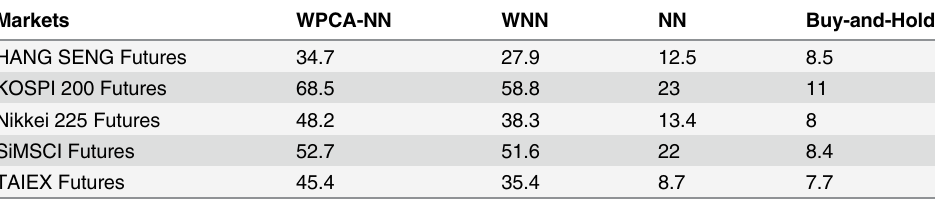
Table 14. Summary of Average Annual Returns from 2005 to 2014.